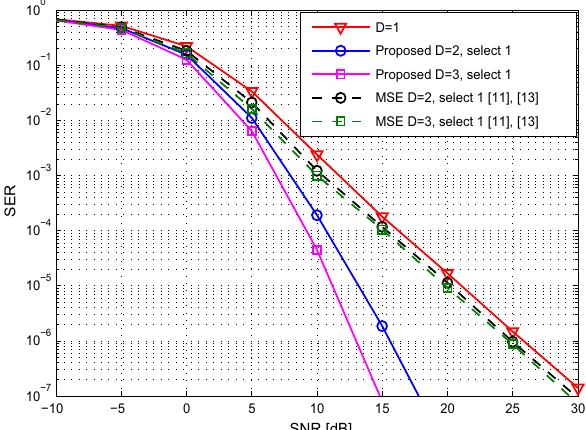
Fig. 3 Performance comparison of the proposed STBC-CQ-PNC with the CQ-PNC in [3]